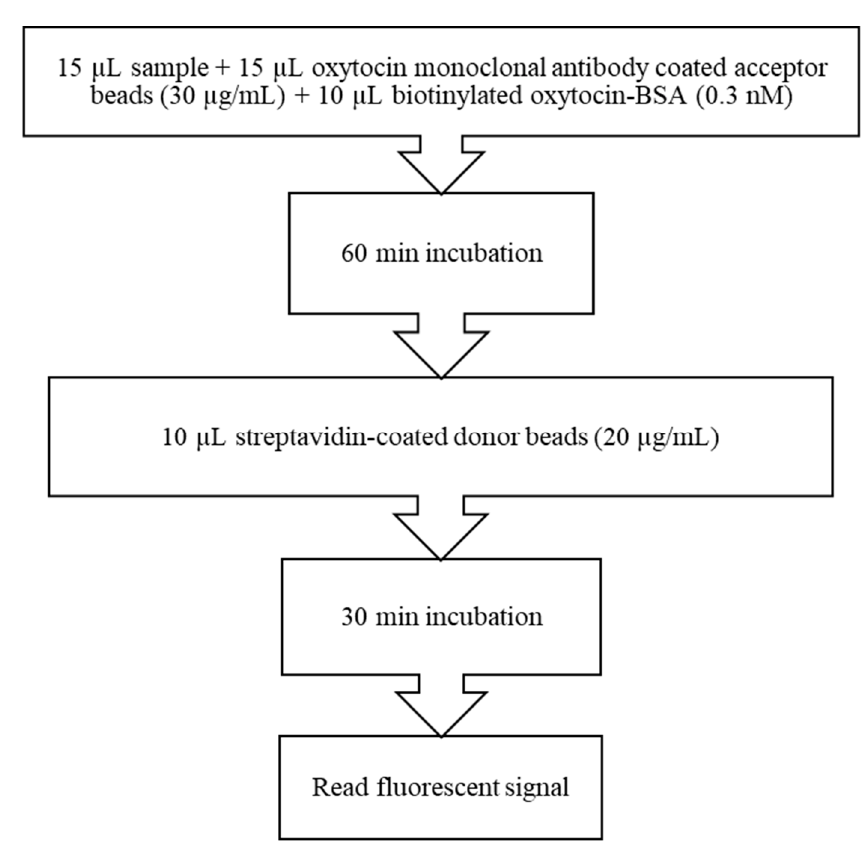
Figure 1. AlphaLISA protocol for hair oxytocin measurement in pigs.